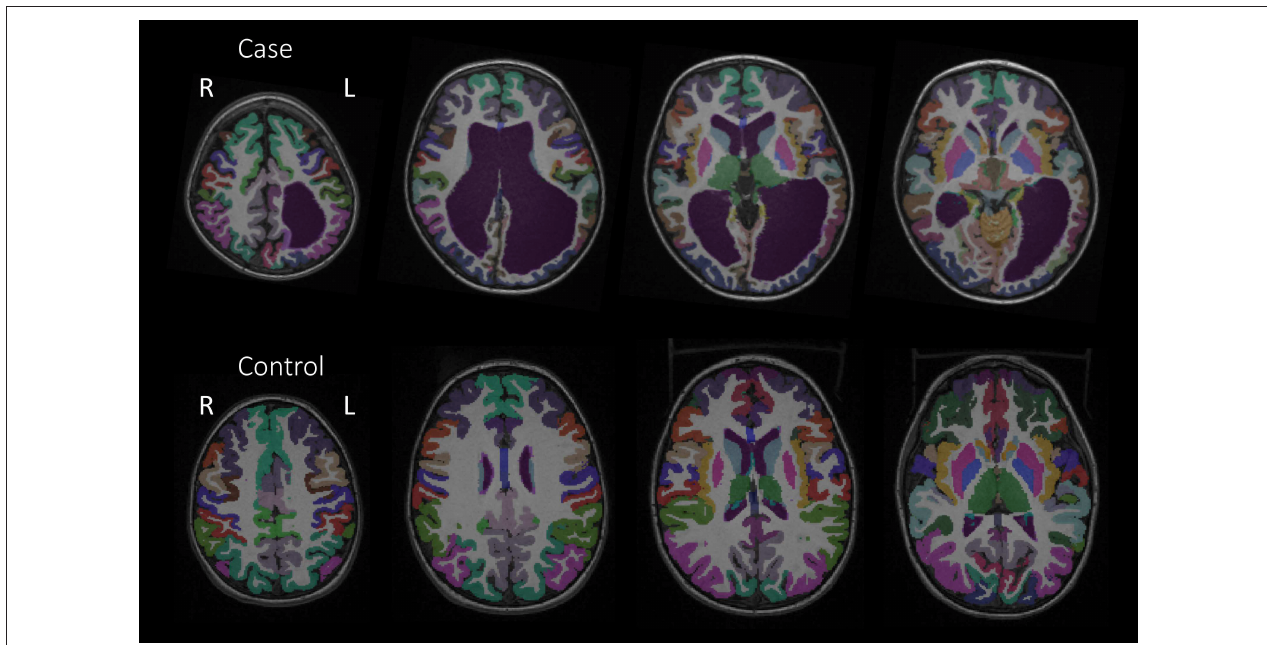
FIGURE 1 | Cortical parcellations from the Desikan-Killiany anatomical atlas of Case 2 and a control to depict anatomical differences.